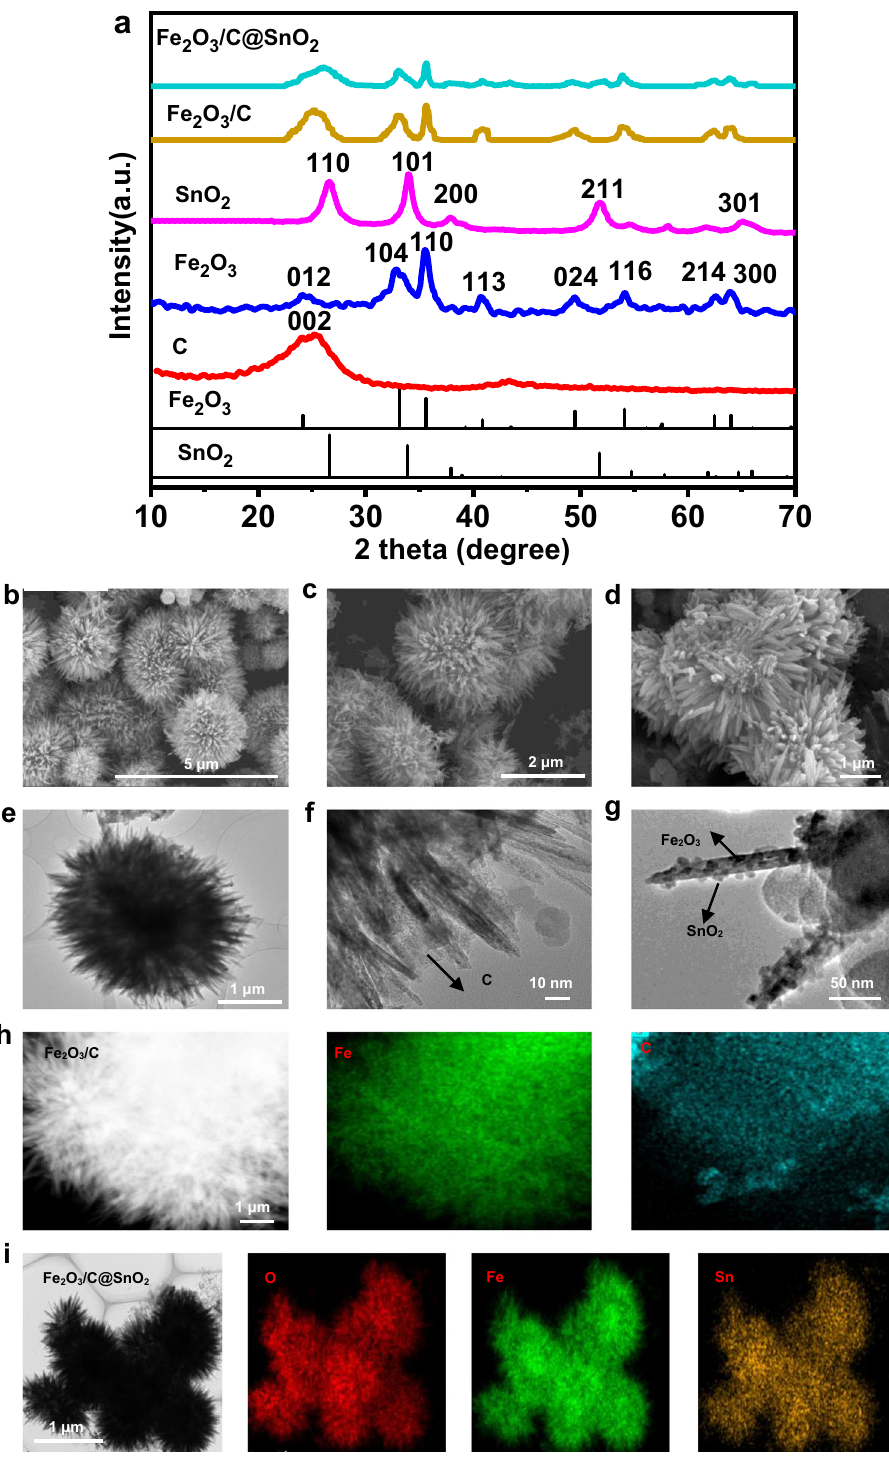
Fig. 2 Fe 2 O 3 , SnO 2 , Fe 2 O 3 /C (3:1), and Fe 2 O 3 /C@SnO 2 (3:1:4) microparticles structure and morphology. a The XRD patterns of acetylene carbon black, Fe 2 O 3 , SnO 2 , Fe 2 O 3 /C (3:1) and Fe 2 O 3 /C@SnO 2 (3:1:4). SEM images of b Fe 2 O 3 , c Fe 2 O 3 /C (3:1), and d Fe 2 O 3 /C@SnO 2 (3:1:4), TEM images of e Fe 2 O 3 , f Fe 2 O 3 /C (3:1), and g Fe 2 O 3 /C@SnO 2 (3:1:4), elemental mapping of h Fe 2 O 3 /C (3:1), and i Fe 2 O 3 /C@SnO 2 The images of Fe 2 O 3 re fl ect a typical sea-urchin-like structure, particles, while the other part of carbon materials was embedded with a diameter of about 3 μ m, as shown in Fig. 2b. Micro- in the gap of Fe 2 O 3 needles, thereby forming a Fe 2 O 3 /C structure. The SEM images of resulting the Fe 2 O 3 /C@SnO 2 (3:1:4), in which structures of the Fe 2 O 3 /C nanocomposites are shown in Fig. 2c, f. In addition, one part of acetylene black carbon encloses Fe 2 O 3 SnO 2 nanoparticles are visible, as shown in Fig. 2g. Moreover, one